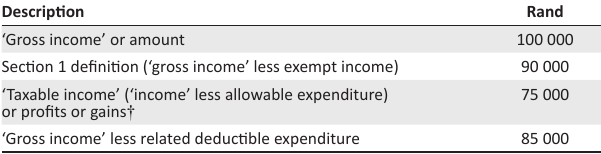
TABLE 2: Possible amounts to be included in taxpayer’s tax return.